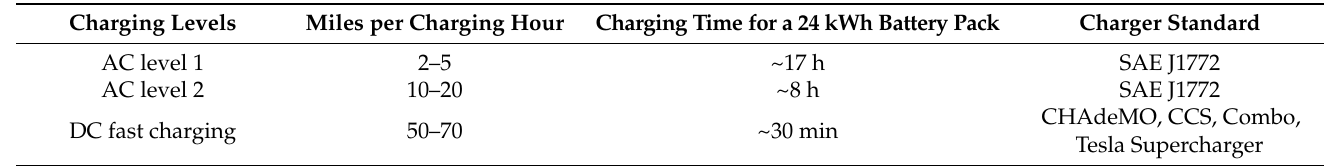
Table 3. Chargers, miles per charging hour and charging times for each level of charging